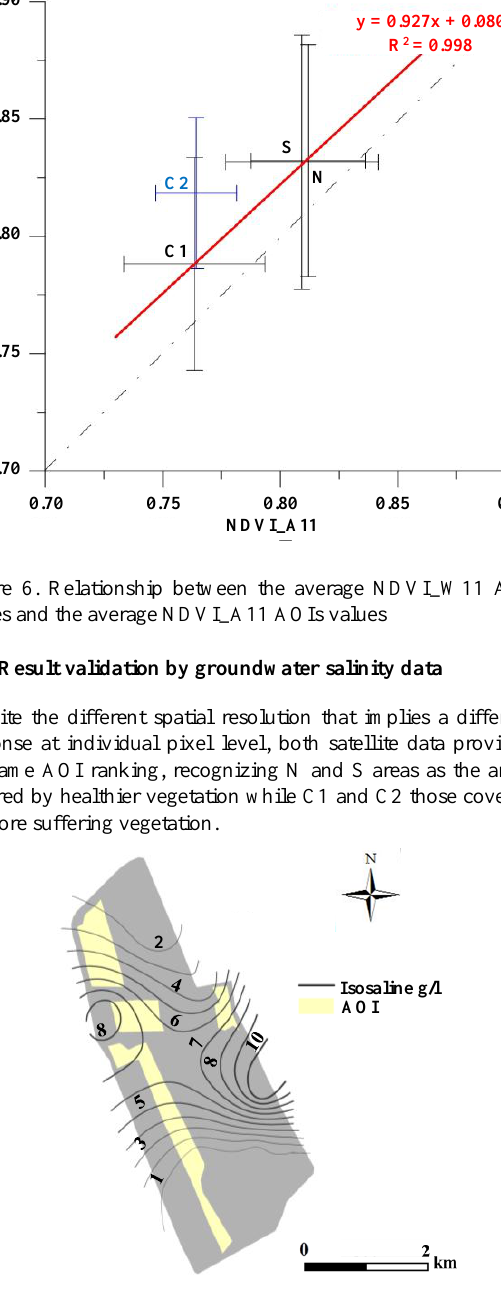
Figure 7. Overlay between the Classe AOI locations and the groundwater salinity isosalines (g/l) of May 2011